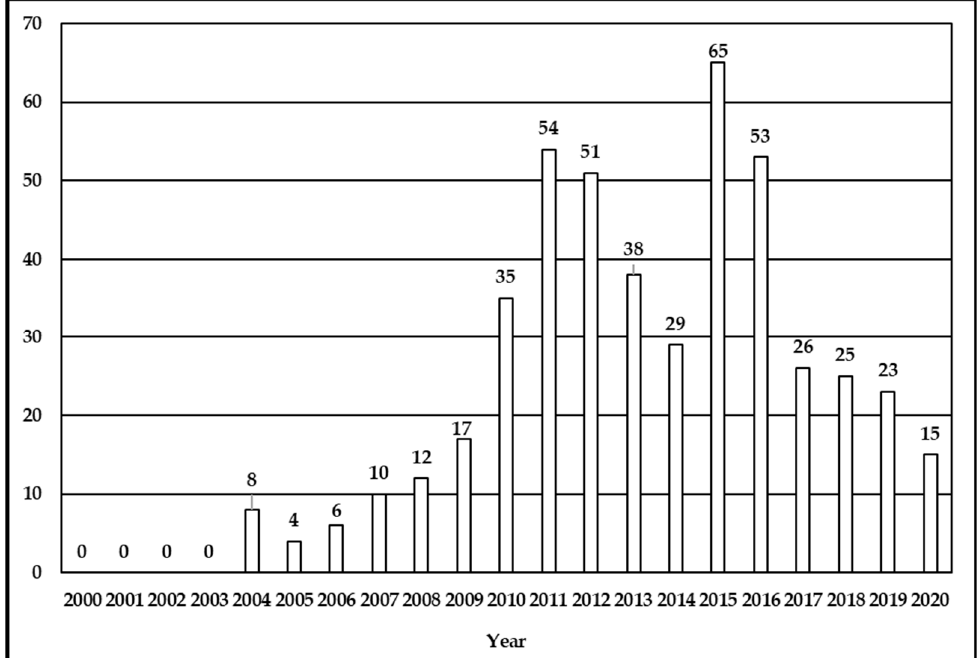
Figure 1. Articles by year, number of articles.